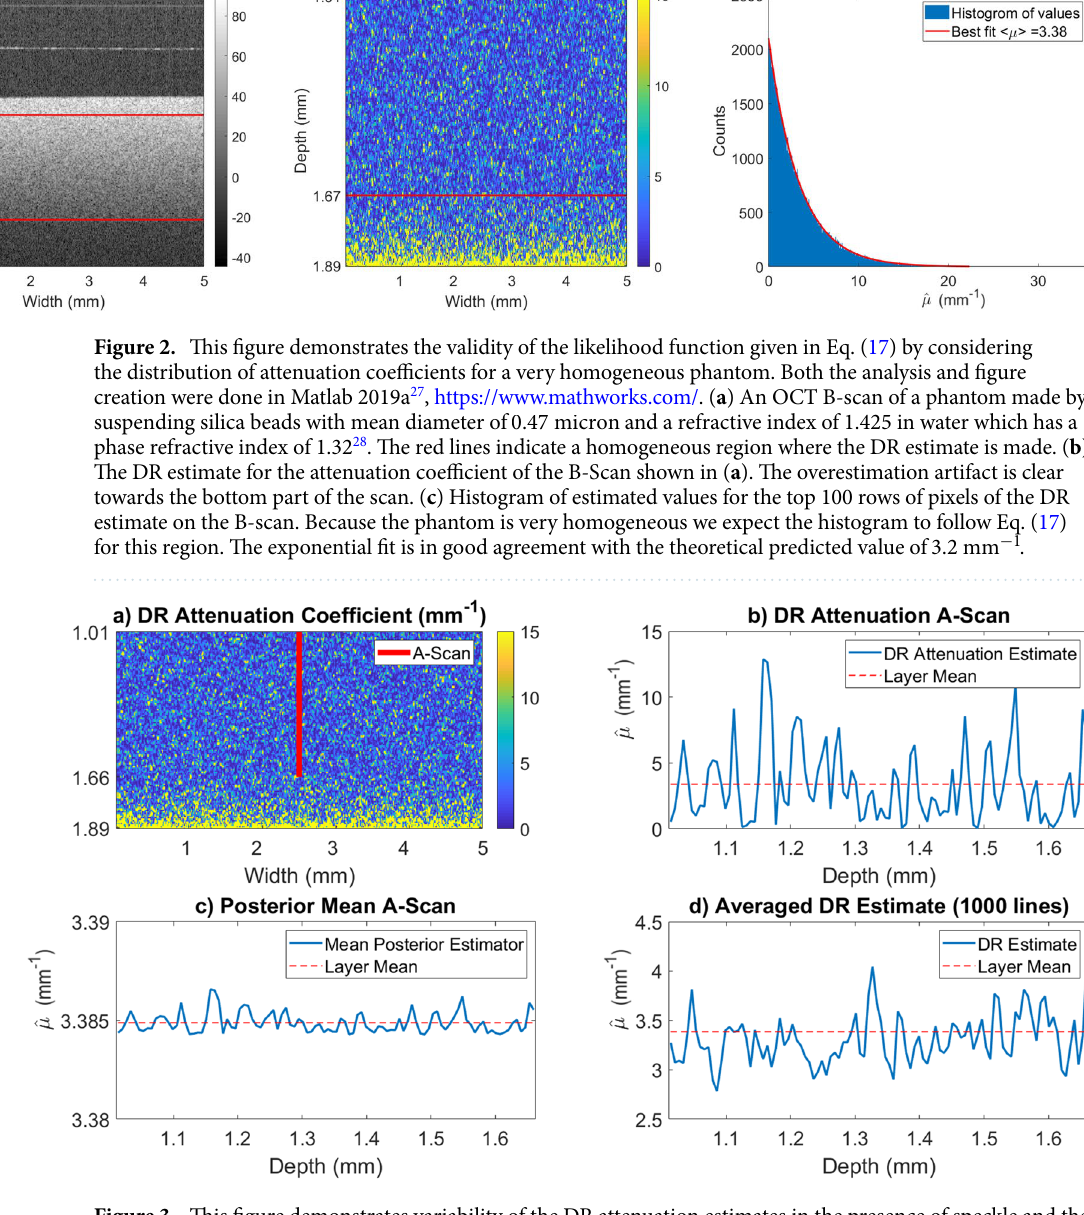
Figure 3. This figure demonstrates variability of the DR attenuation estimates in the presence of speckle and the Bayesian estimator for the attenuation coefficient given in Eq. (26). Both the analysis and figure creation were done in Matlab 2019a 27 , https ://www.mathw orks.com/. ( a ) The DR estimate for the attenuation coefficient of the B-Scan is shown in Fig. 2. The red line is the portion of the scan considered in ( b ). ( b ) Plot of the DR estimate for the A-scan extracted from ( a ). This estimate shows how highly variable the DR attenuation coefficient appears to be in the presence of speckle. ( c ) Mean of the Posterior estimate for the extracted A-scan. This was 1 3.38 mm µ oct computed using the which is the layer mean for the first 100 rows of pixels of the B-scan. − � � = 6 2 mm 1 10 6.0053 10 The value of ζ was computed to be ζ from a voxel volume of 3.2 micron and − − − × = × 9 mm 2 1.9 10 a scattering cross section of σ scat . ( d ) Comparative DR estimate for the average of all 1000 − = × A-lines in the B-scan. The resulting fluctuations are still very large even after averaging 1000 2.00 mm − 1 . Once the deterministic signal is modeled we generate the OCT signal per voxel coefficient of µ oct = as a realization of an exponential random variable with parameter given by the true coefficient as in Eq. (6). This random realization can be seen in Fig. 4a. The attenuation coefficient was estimated using the DR method given in Eq. (8) and is shown in Fig. 4b. The reconstruction equation becomes inaccurate near the bottom of the measurement volume, preventing accurate estimation. To avoid these inaccuracies the deepest 30% of the reconstructed attenuation coefficients were truncated. The 30% value was arrived at by inspection. In Fig. 4c we fit an exponential model to the histogram of the reconstruction and see that the best fit parameter agrees with